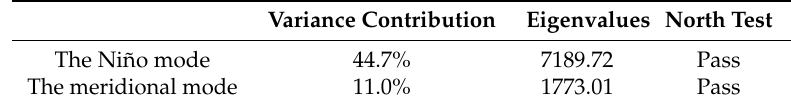
Table 3. Variance contribution and eigenvalues of EOF analysis results for SST